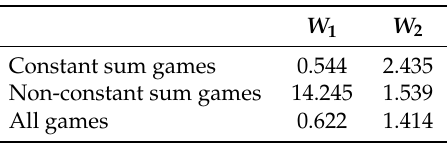
Table A2. CBL Normalized weights.